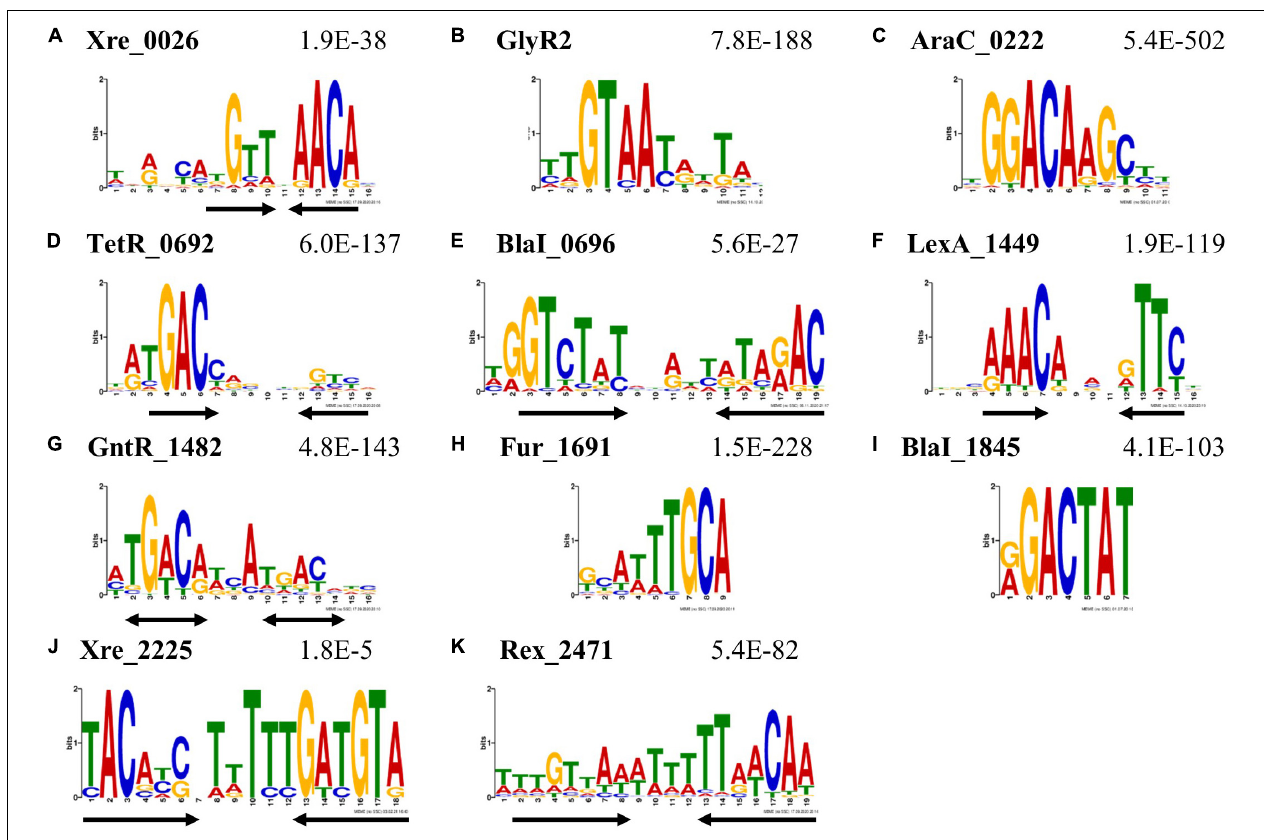
FIGURE 2 | DNA sequence motifs enriched among DAP-seq peak sequences. These sequence logos represent the putative TF-DNA binding motifs derived from DAP-seq peak sequences using MEME-ChIP. The locus tag of the TF and the E -value estimating the frequency of finding such a motif by random chance are listed above each sequence logo. Black arrows beneath the logos indicate the location and orientation of symmetric elements. Motifs were found for TFs of various types: (A) Xre _0026; (B) GlyR2; (C) Xre_0222; (D) TetR _0692; (E) BlaI _0696; (F) LexA _1449; (G) GntR _1482; (H) Fur _1691; (I) BlaI _1845; (J) Xre_2225; and (K) Rex _2471. The black double arrows (G) indicate potentially palindromic sequences. See the Supplementary Material for input files and raw sequences contributing to these